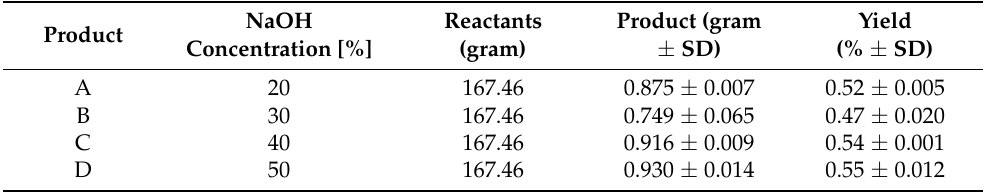
Table 2. Percentage yield of AgNPs-chi-spheres at various concentrations of NaOH. The preparation of AgNPs-chi-spheres were performed in duplicates.